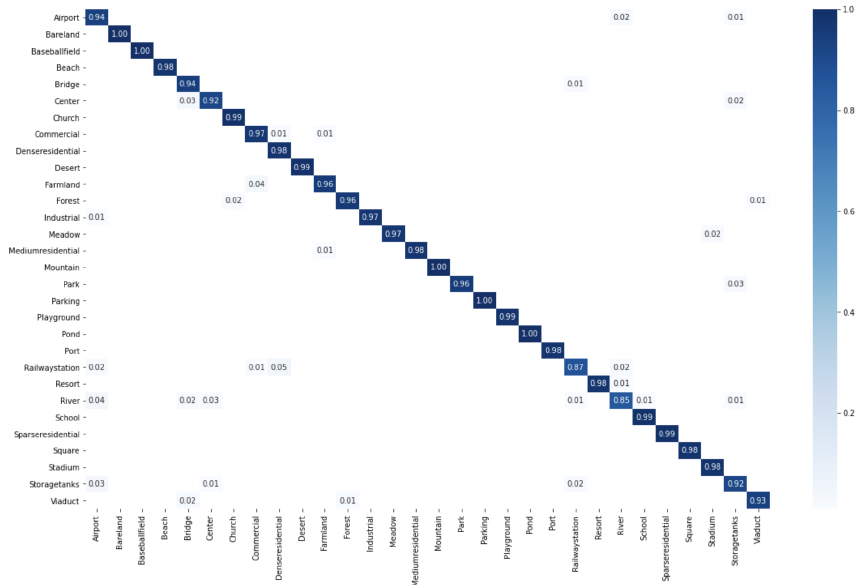
Figure 11. Confusion matrix of our method under the 50% training ratio and 90% of important features on the AID data set.